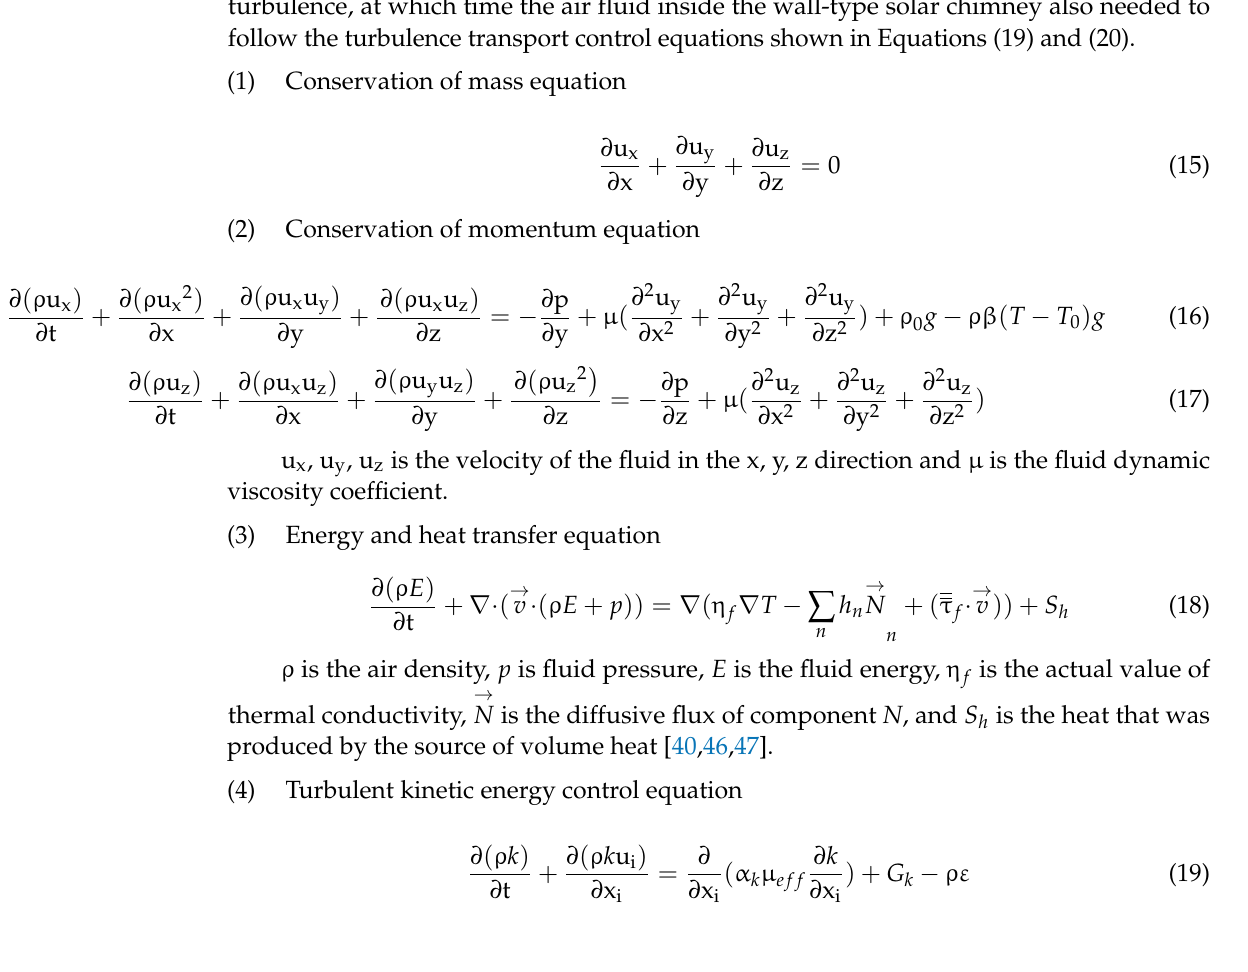
Figure 5. The computational error of adjacent grids.